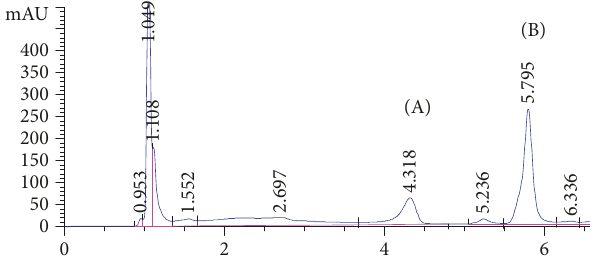
Figure 3: HPLC-PDA chromatogram of (A) atenolol 25 𝜇 g/mL and (B) trimetazidine 25 𝜇 g/mL in urine sample.